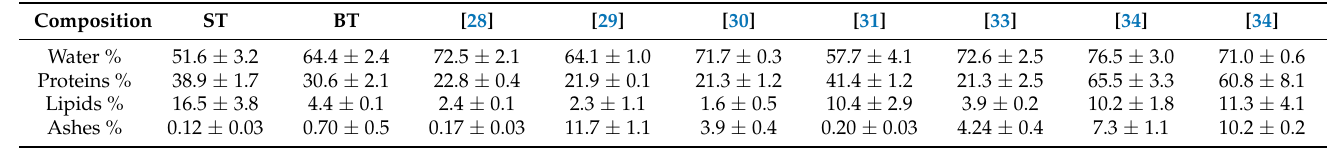
Table 1. General composition of ST and BT skin in comparison with literature data about Tilapia skin composition. Results are expressed as mean value ± SD.